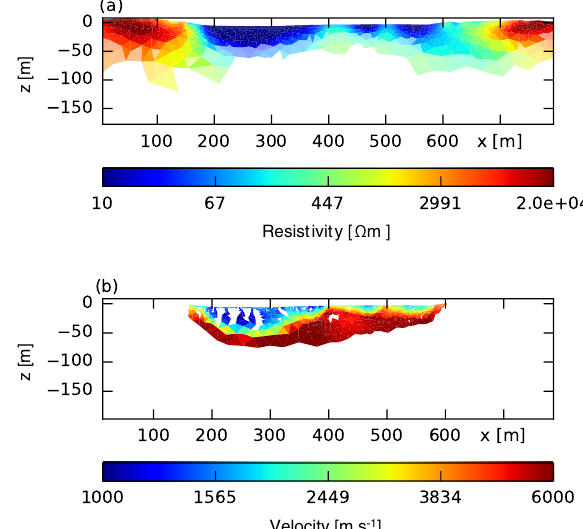
Figure 8. Separated inversion results of the ERT data set (a) and the refraction seismic data (b) . The shading is based on the